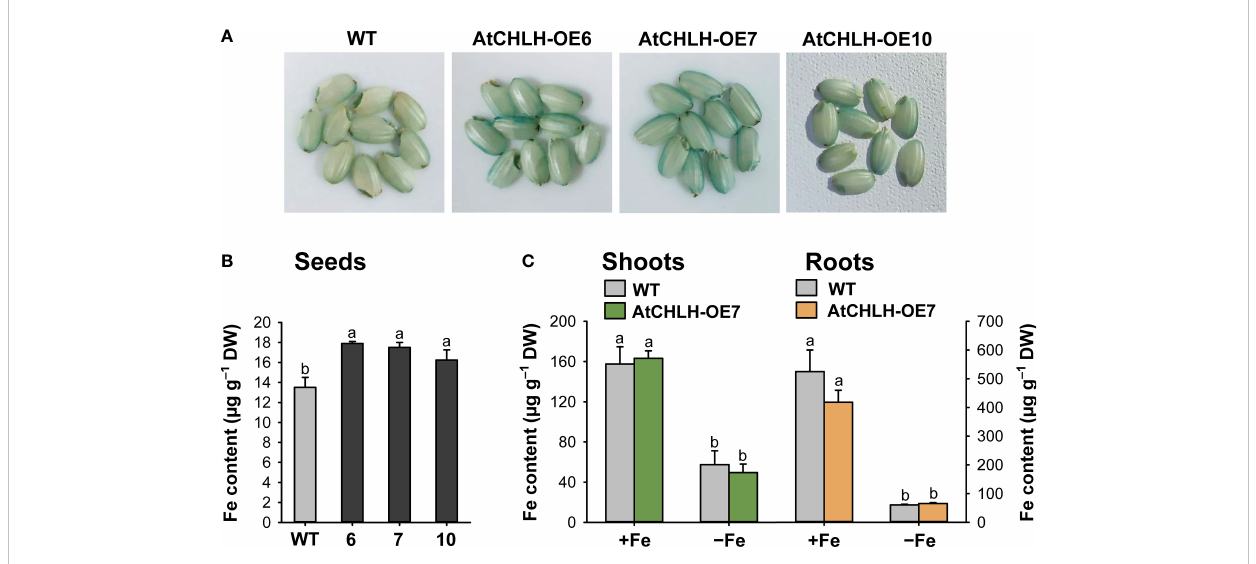
FIGURE 7 Fe contents in different tissues of WT and transgenic plants. (A) Fe localization in rice seeds by Perls staining. (B) Fe contents in seeds by ICP-OES. (C) Fe contents in shoots and roots under Fe-suf fi cient and Fe-de fi cient conditions by ICP-OES. For obtaining shoots and roots, the plants were subjected to the same treatments as in Figure 3. Treatment notations are the same as in Figure 3. Values are means ± SE, and data from three independent experiments are presented. Different letters indicate signi fi cant differences at P < 0.05 by Duncan ’ s multiple range test. DW, dry